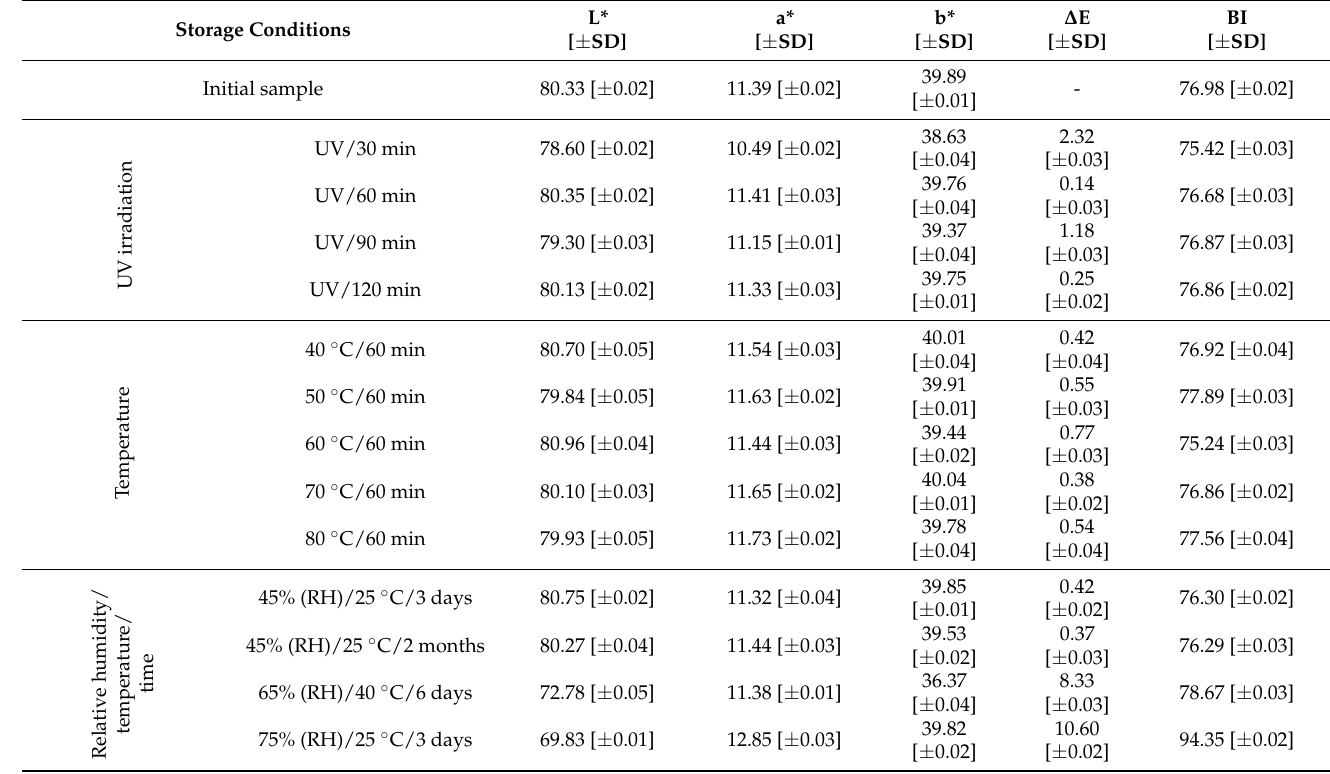
Table 2. Analysis of color in the CIE L*a*b* space, total color difference ( ∆ E), and browning index (BI) parameters for gum tragacanth storage in different